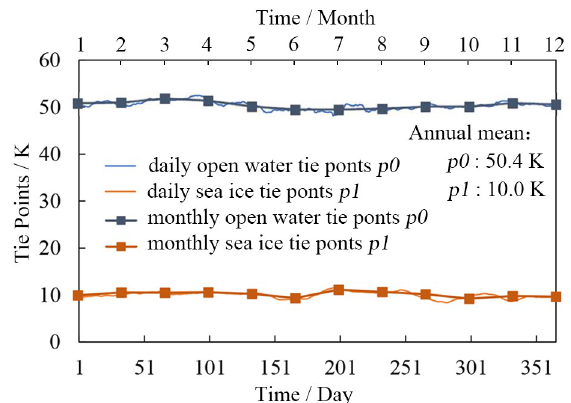
Figure 1. Daily (solid curves) and monthly (solid curves with squares) FY-3D MWRI ASI tie points p0 for open water (blue) and p1 for sea ice (orange) in